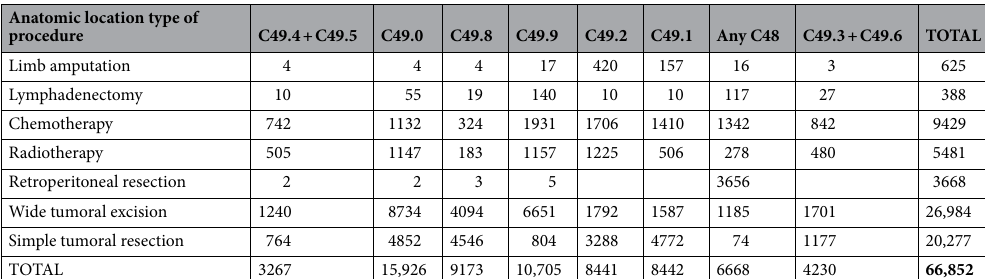
Table 4. Distribution of procedures based on anatomic location.